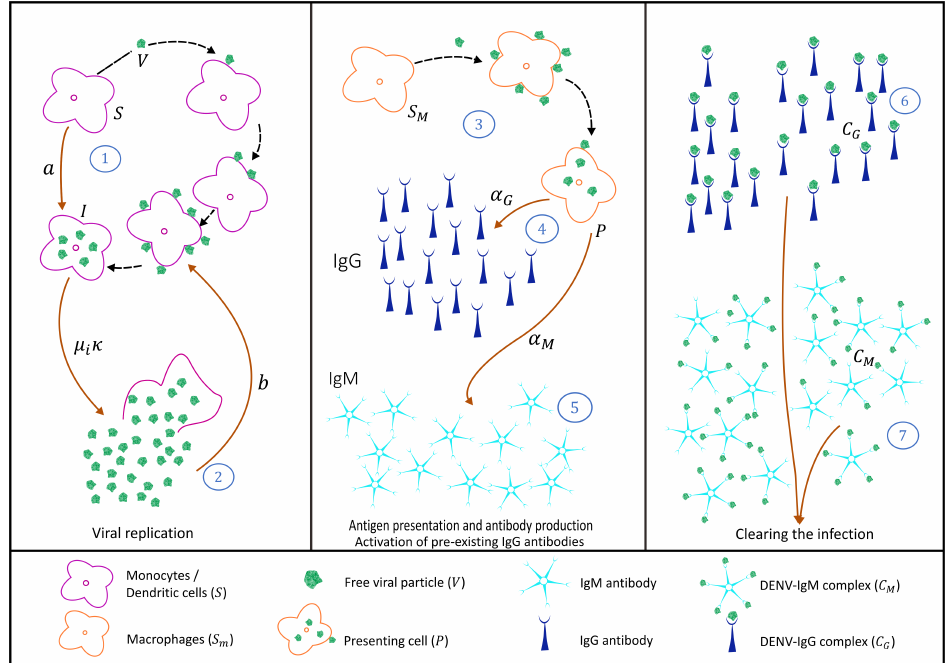
Figure 6. Schematic in-host dengue immunological responses mediated by antibodies: secondary infection with the same dengue serotype. Three blocks are used to describe 7 steps during the infection, from viral replication up to infection